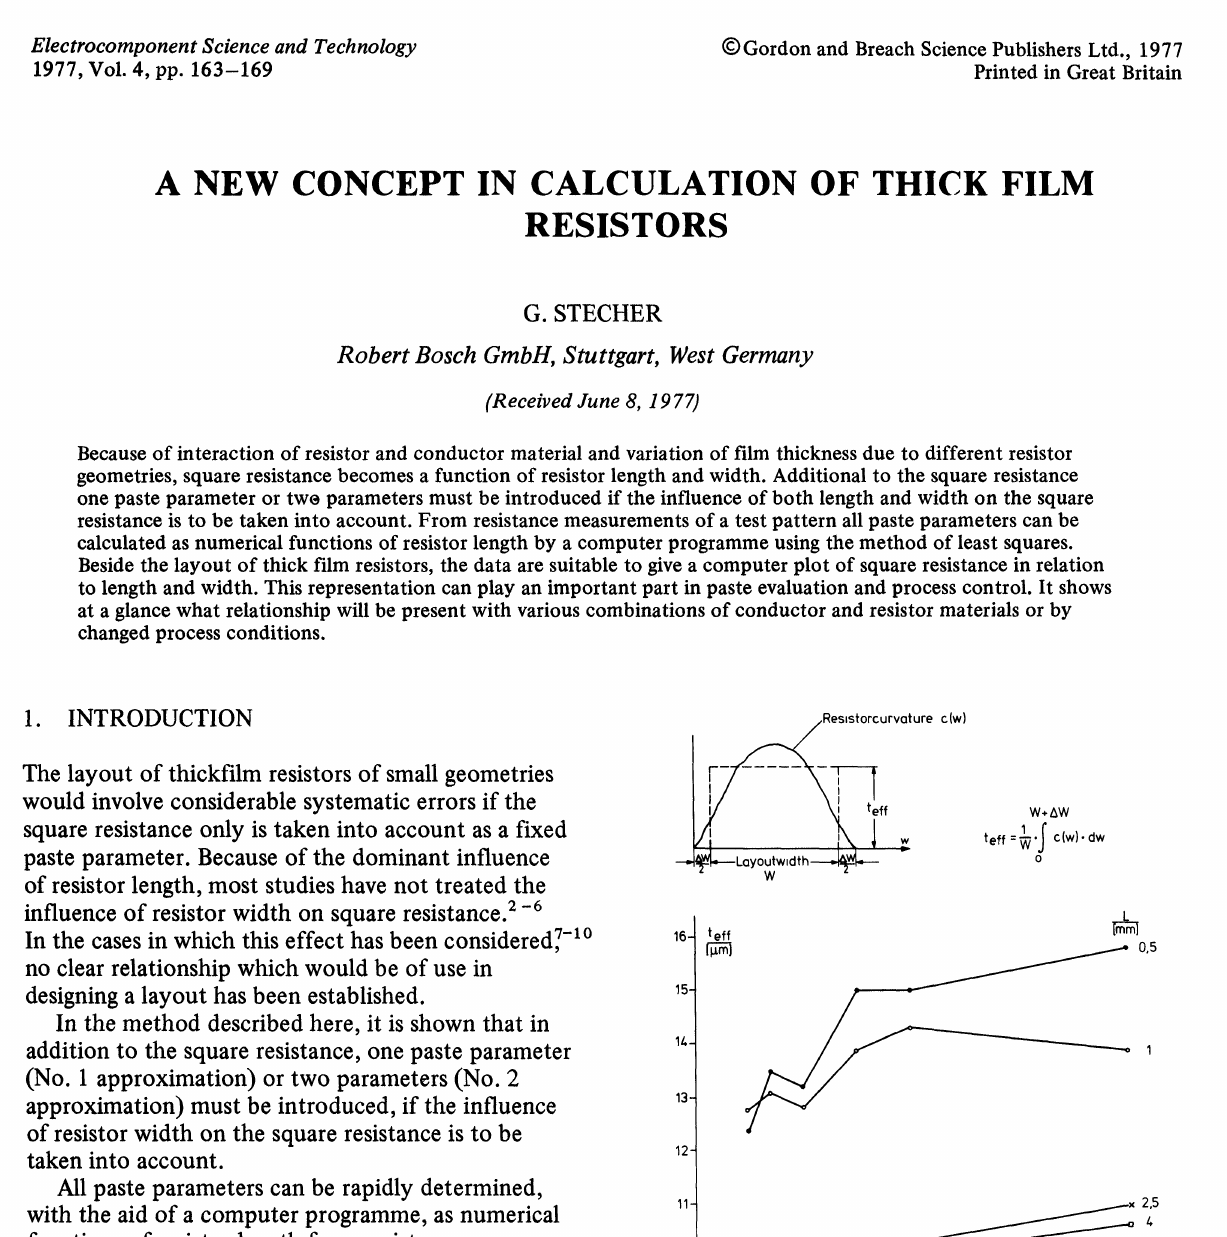
FIGURE Effective thickness tef f of thick film resistors as a function of resistor width W (Parameter: length L). resistor geometry. The film thickness relations can 163